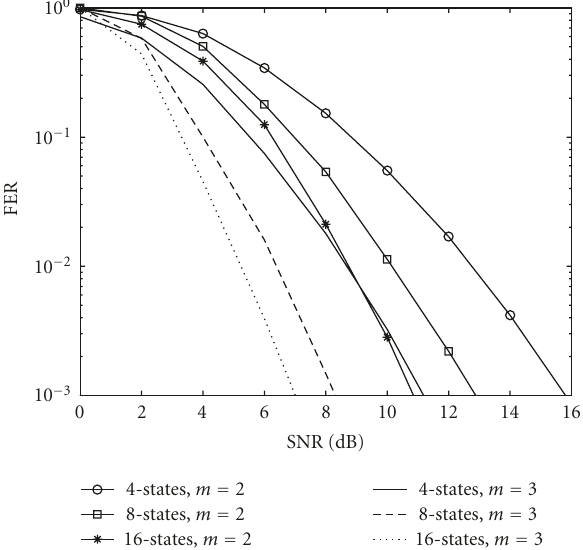
Figure 3: FER versus SNR for STCCs over Z 4 for 4-PSK based on the trace criterion with n = 3, m = 2,3, and 4,8, and 16 states.